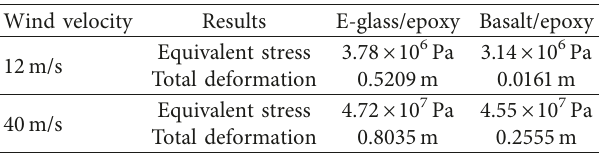
Figure 12: FEM boundary conditions. Table 5: Structural results for the basalt-epoxy and E-glass-epoxy wind blade